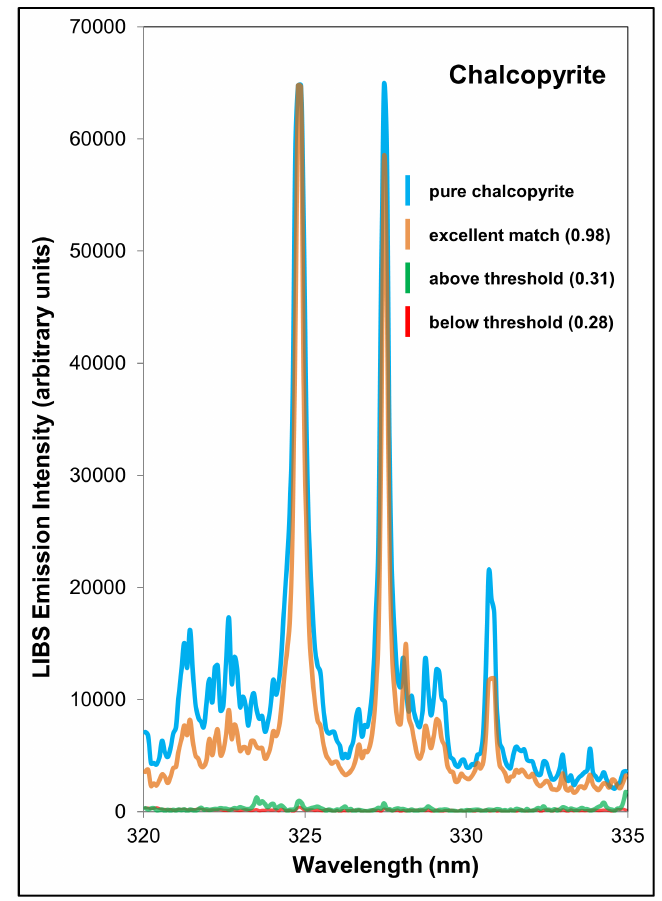
Figure 18. Example of a Pearson spectral match value for a series of unknown spectra with spectral matches just above the 0.3 cuto ff threshold (green), just below that threshold (red), and well above the threshold (orange) compared to a pure chalcopyrite mineral spectrum (blue). The Pearson spectral match threshold values were selected by analyzing this relationship for numerous unknown